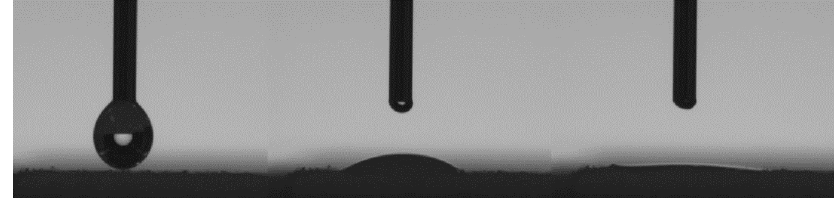
Figure 3. Wetting behavior of the polyvinylidene fluoride (PVDF)–acetone solution onto a nylon 12 SLS sample.